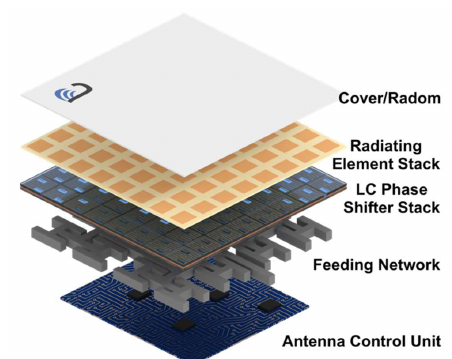
Figure 36. Microwave Liquid Crystal (MLC)-based phased array layout for a basic module. Courtesy of ALCAN Systems GmbH.